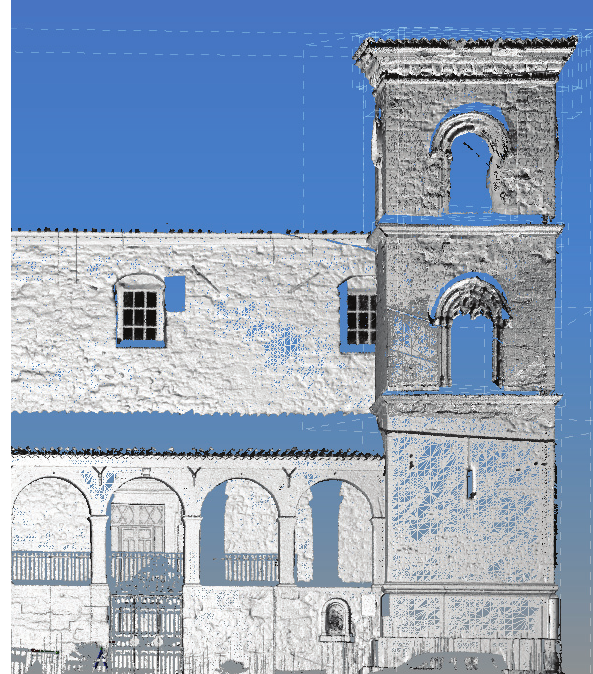
Figure 9. Porch and bell tower poligonal model